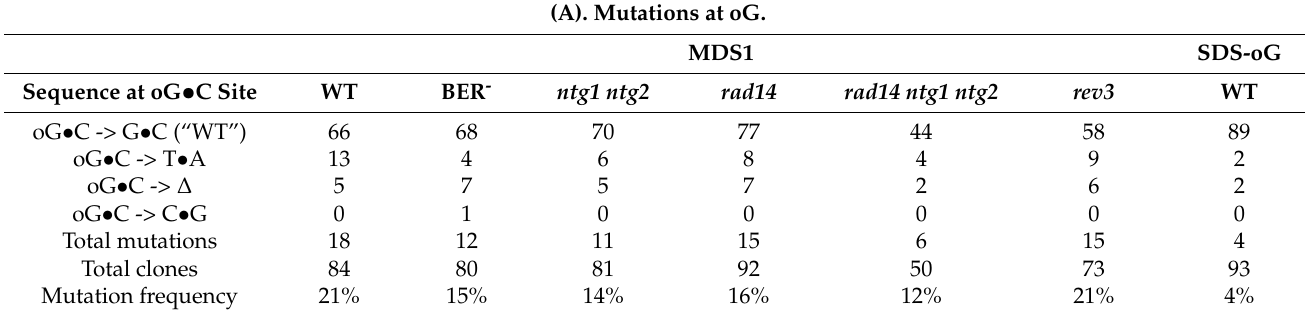
Table 2. Mutation type and frequency at oG, hU, and fU in MDS1 in DNA repair-deficient strains. (A). Mutations at oG.